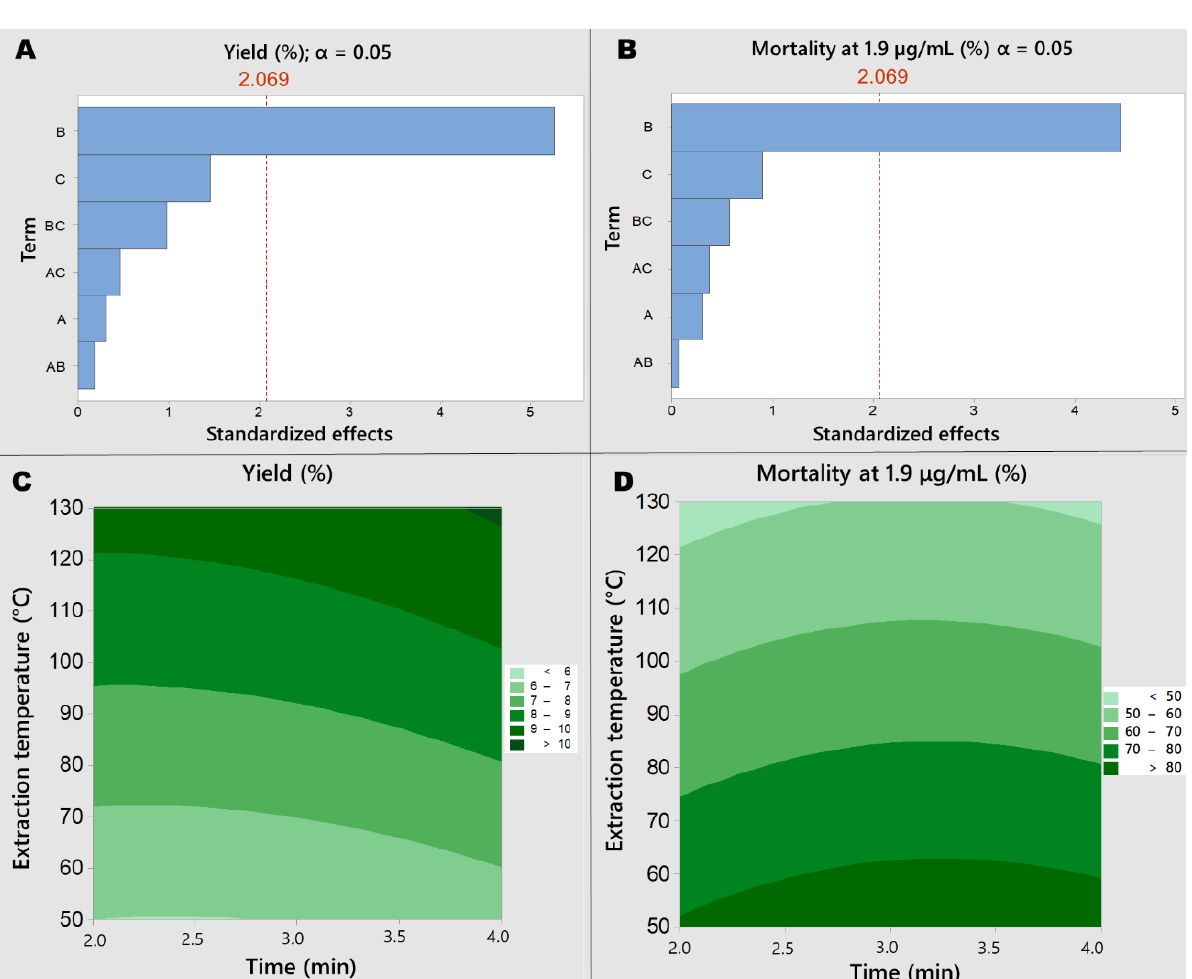
Figure 3. Pareto charts and contour scales of the responses applying Box – Behnken design to Piper nigrum extractions. ( A ): Pareto chart for yield. ( B ): Pareto chart for Aedes aegypti larvae mortality (1.9 µ g/mL, 24 h). y-axis Term: A-time; B-temperature; C-sample quantity. Broken red line indicates statistically significant effects (Student’s t -test, 95% confidence level). ( C ): contour scale for yield. ( D ): contour scale for Aedes aegypti L3 larvae mortality (1.9 µ g/mL, 24 h). Sample quantity: 3